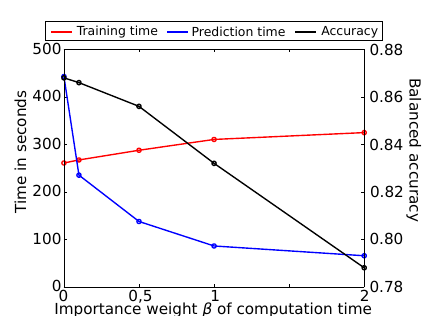
Figure 6. Influence on computation time and accuracy by time sensitive node